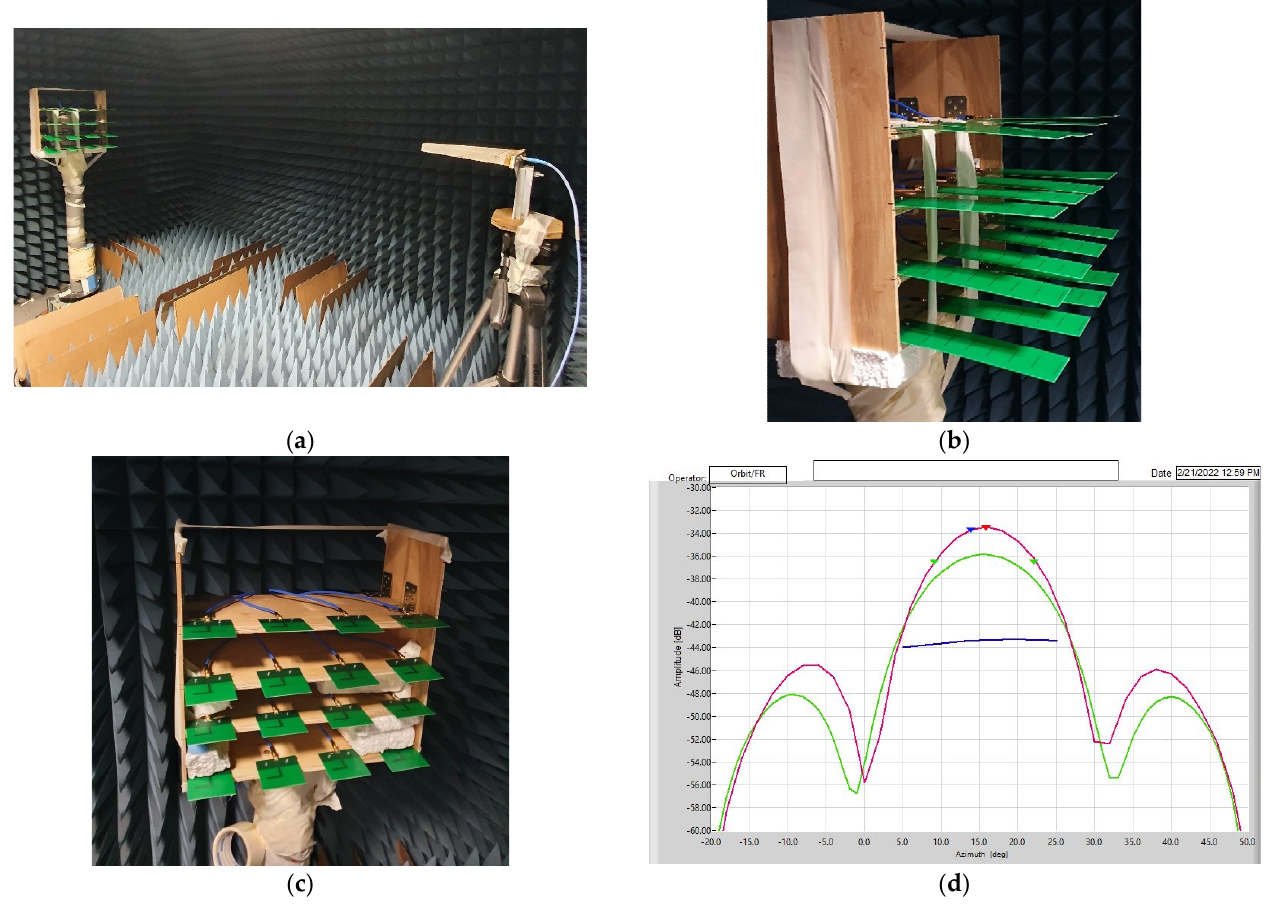
Figure 16. ( a ) Farfield antenna measurement setup; ( b ) Full 4 × 4 Yagi array; ( c ) Full 4 × 4 Yagi array; ( d ) Pattern 4 × 4 array of Yagi elements vs. dipole elements and reference antenna without scanning at 2.4 GHz.